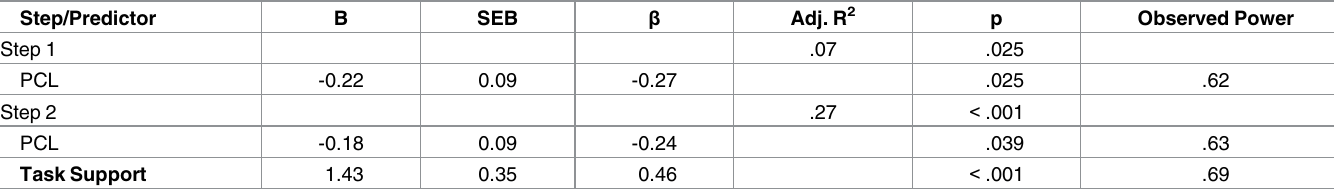
Table 5. Regression analysesfor hypothesis 4: Criterion variable for all analysesis Job in General (job satisfaction).